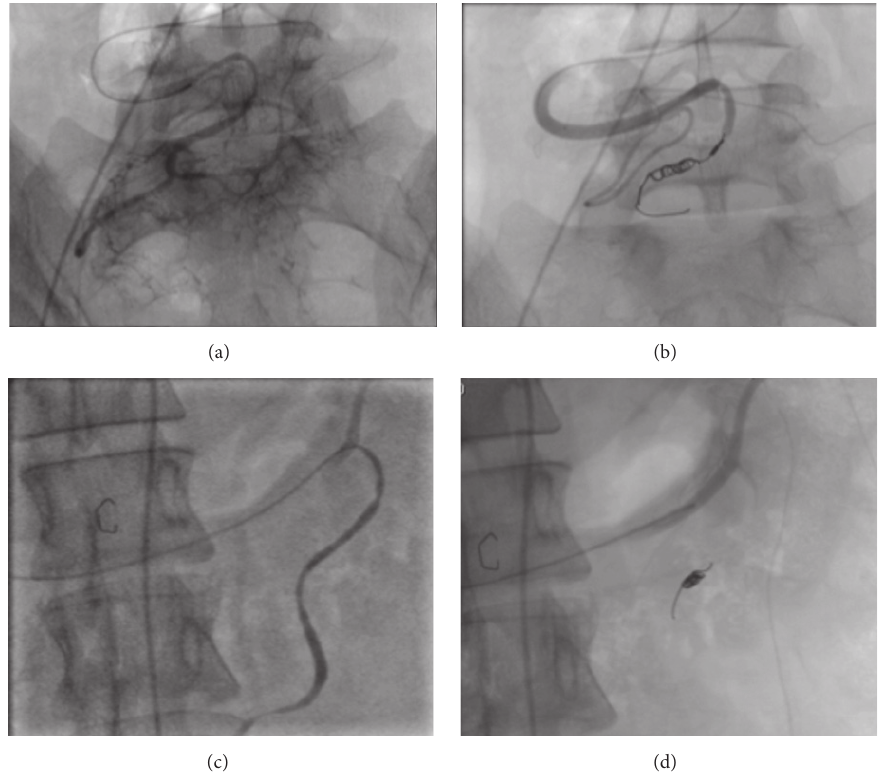
Figure 4: Conventional angiography of right gastroepiploic artery. The omental branch of right gastroepiploic artery was embolized using coilsatitsdistalmostend((a)and(b))andatproximalend((c)and(d)).Postembolizationimages((b)and(d))showedcompleteembolization of this artery.